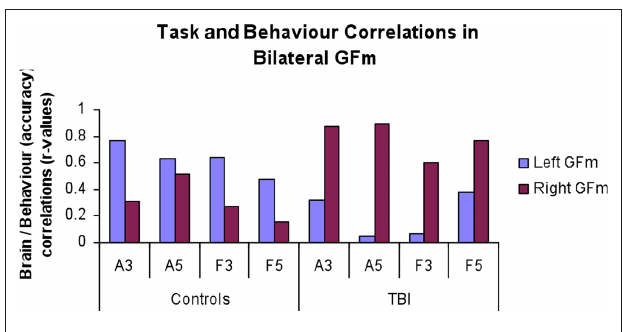
FIguRe A1 | Correlations between brain activity in anterior middle frontal gyrus seed regions (highlighted in Figure 3A). Talairach coordinate of left middle frontal gyrus (GFm): − 40, 48, 23; right GFm: 40, 47,